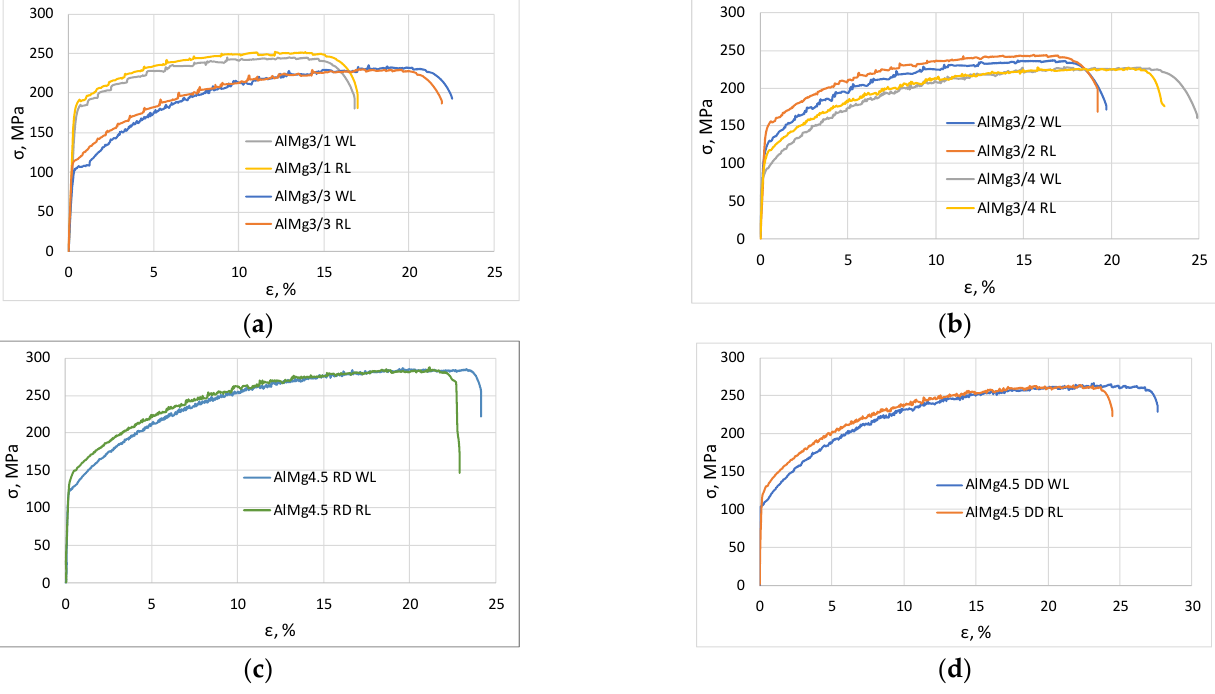
Figure 6. Typical tensile test results; ( a ) AlMg3/1 and AlMg3/3; ( b ) AlMg3/2 and AlMg3/4; ( c ) AlMg4.5 Rolling direction; ( d ) AlMg4.5 Diagonal direction. Table 2. Results of tensile tests — average values of all specimens.